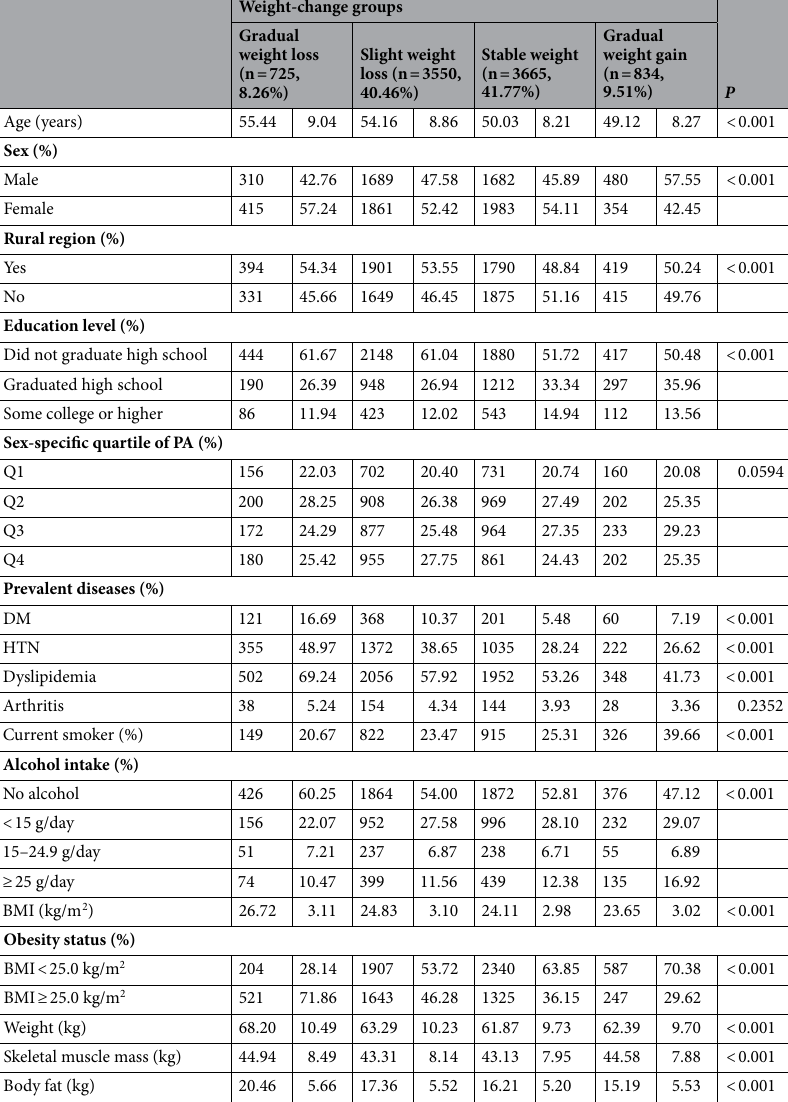
Table 1. Basic characteristics of weight-trajectory groups. PA physical activity, DM diabetes mellitus, HTN hypertension, BMI body mass